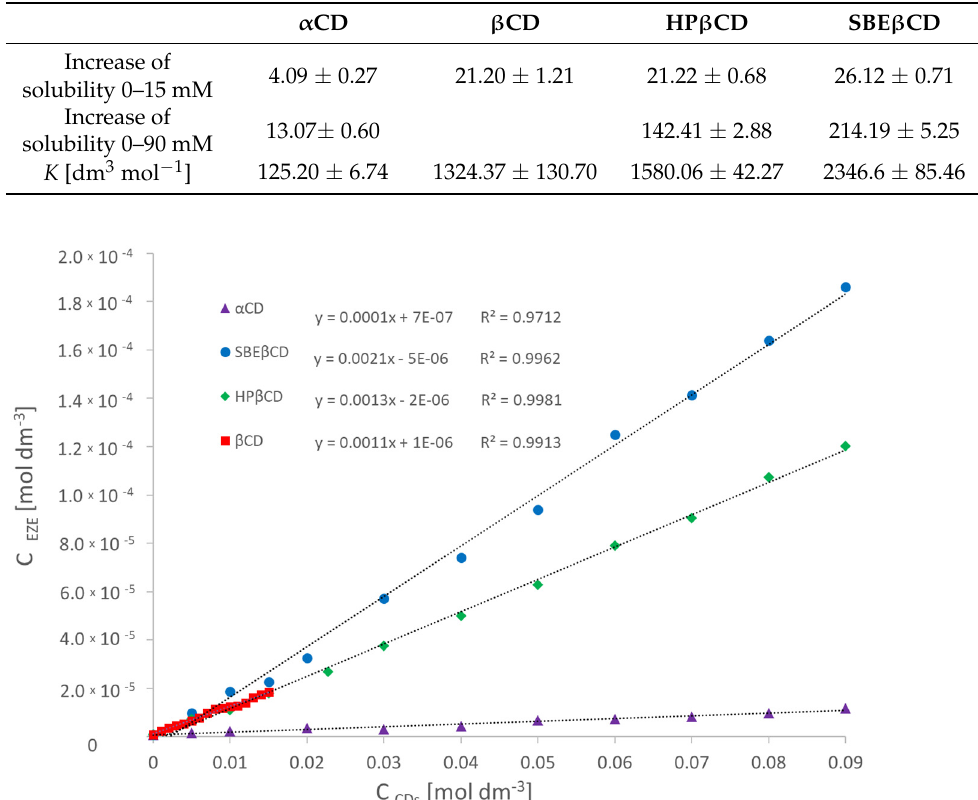
Figure 6. The dependence of solubility increases of ezetimibe in water on increasing concentration α CD ( (cid:78) ), HP β CD ( (cid:7) ), SBE β CD ( • ) (1–90 mM), and β CD ( (cid:4) ) (5–15 of α CD ( ▲ ), HP β CD ( ♦ ), SBE β CD ( ● ) (1–90 mM), and β CD ( ■ ) (5–15 mM).